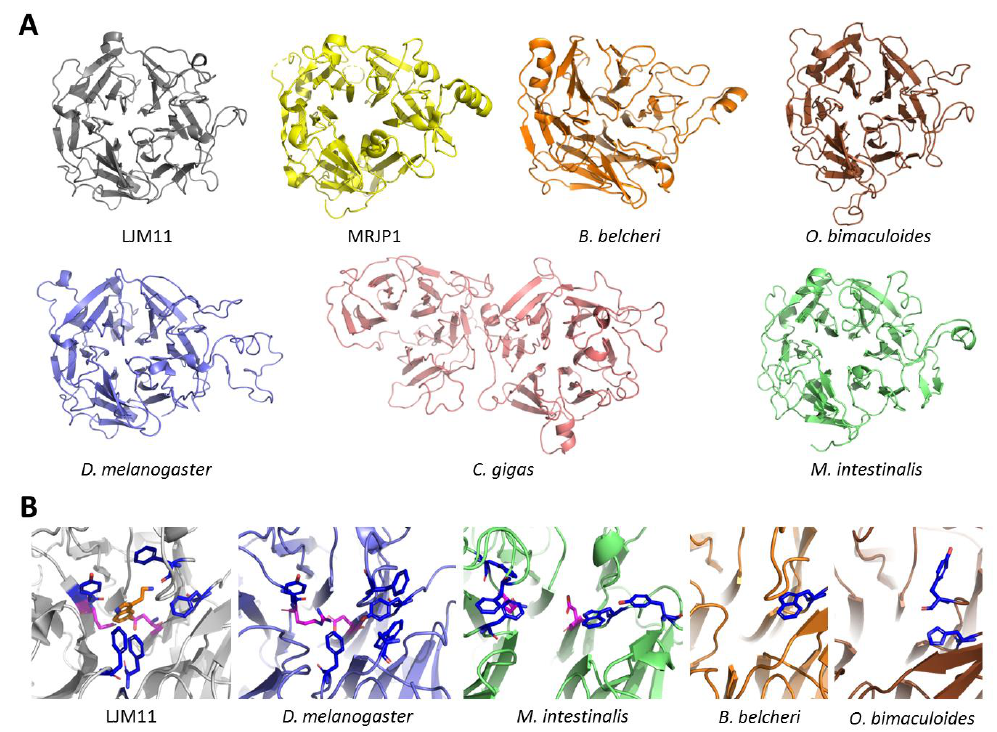
Figure 4. Comparison between the structure of LJM11 (PDB ID: 3q6k), MRJP1 (PDB ID: 5yyl) and the structure models of DCE / yellow proteins of B. belcheri , O. bimaculoides , D. melanogaster , C. gigas and M. intestinalis . Panel A: general view of the 6-bladed β -propeller fold of the templates and the models. Panel B: detail of the pore entrance of LJM11 compared to the DCE / yellow proteins of D. melanogaster, M. intestinalis , and B. belcheri . The serotonin molecule is colored in orange, the aromatic residues and the conserved Gln / Arg-Asp residues that divide the pores in two pockets are shown in blue and magenta, respectively.